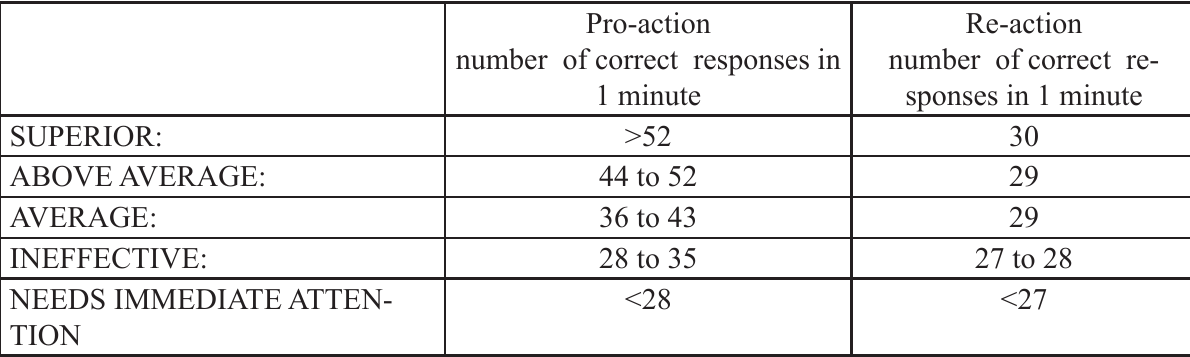
Table 9: The norms obtained for Eye-Hand-Coordination on the Wayne Saccadic Fixator